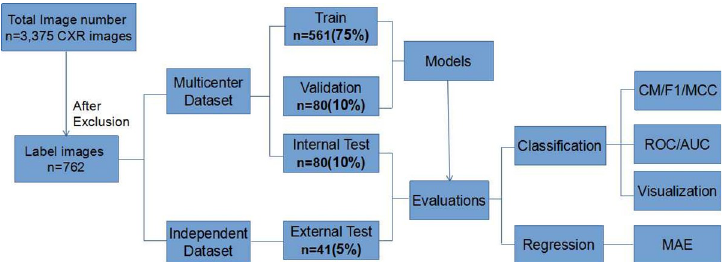
Fig 1. Workflow diagram illustrating the overall experimental design. It described the flow of CXR images through labeling process followed by training transfer learning models using multicenter data and evaluating the models with internal multicenter testing data and independent external testing data. The labeled images were chosen from the initial total dataset according to diagnostic criteria and sufficient quality. CM, confusion matrix; MCC, Matthews correlation coefficient; ROC, receiver operating characteristic; AUC, the area under the curve; MAE, mean absolute error.